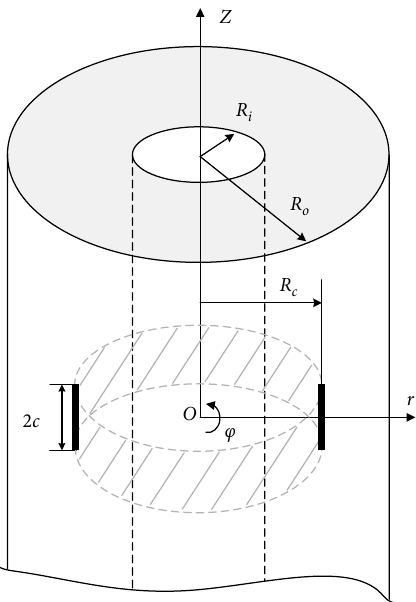
Figure 1: An infinitely long, FG hollow cylinder with a cylindrical